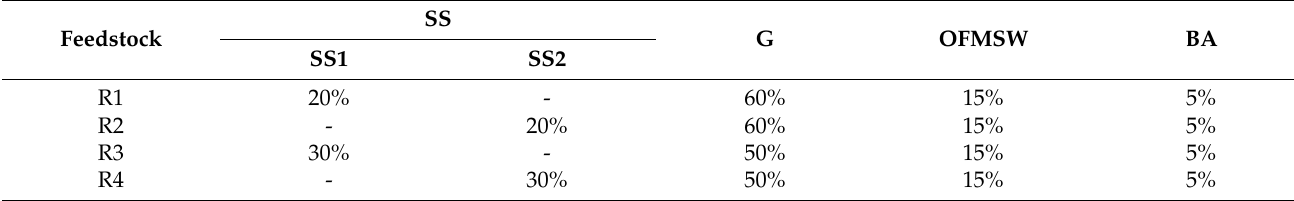
Table 1. Composition of the compost mixture (%, w / w ).